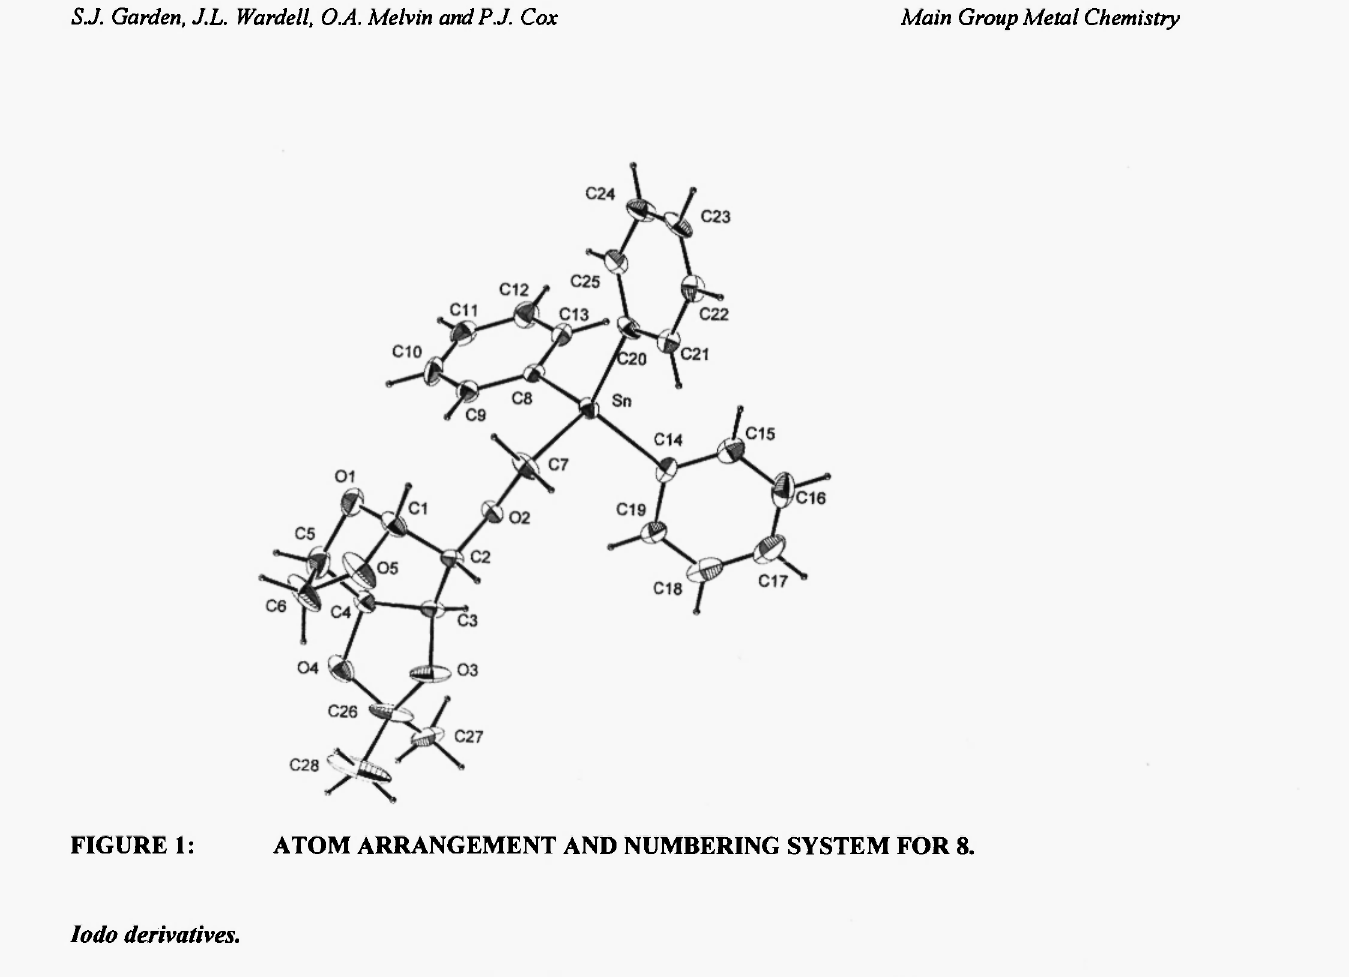
FIGURE 1: ATOM ARRANGEMENT AND NUMBERING SYSTEM FOR 8.